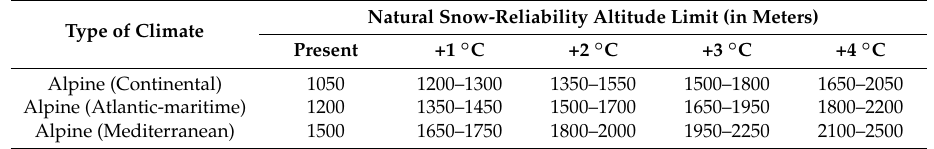
Table 2. Natural snow-reliability altitudes according to climate type and climatic